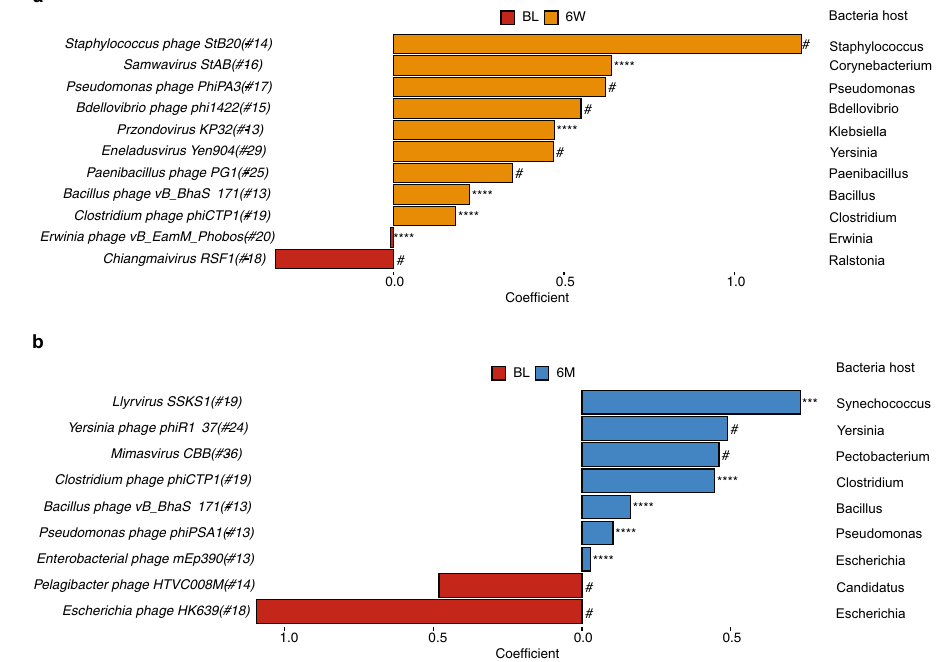
Fig. 3 | Signi fi cantly altered viral taxa after H. pylori eradication therapy. a , b Signi fi cantly altered viral taxa at ( a ) 6-week and ( b ) 6-month compared to baseline using MaAsLin2 (adjusted for age, gender, treatment regimens, drug durations, and the number of raw reads; baseline was set as reference group). Coef fi cientwasobtainedfromMaAslin2outputandonlythosesigni fi cantlyaltered